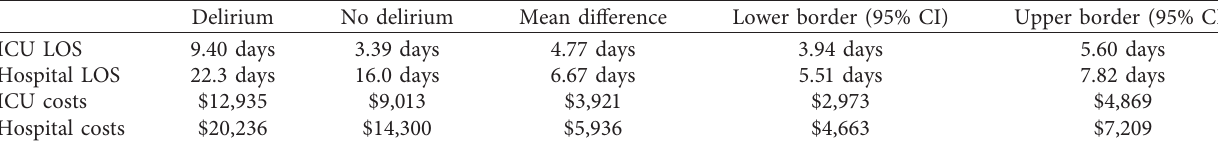
Table 2: Summary of ICU and hospital length of stay and associated costs for patients with and without delirium. Delirium No